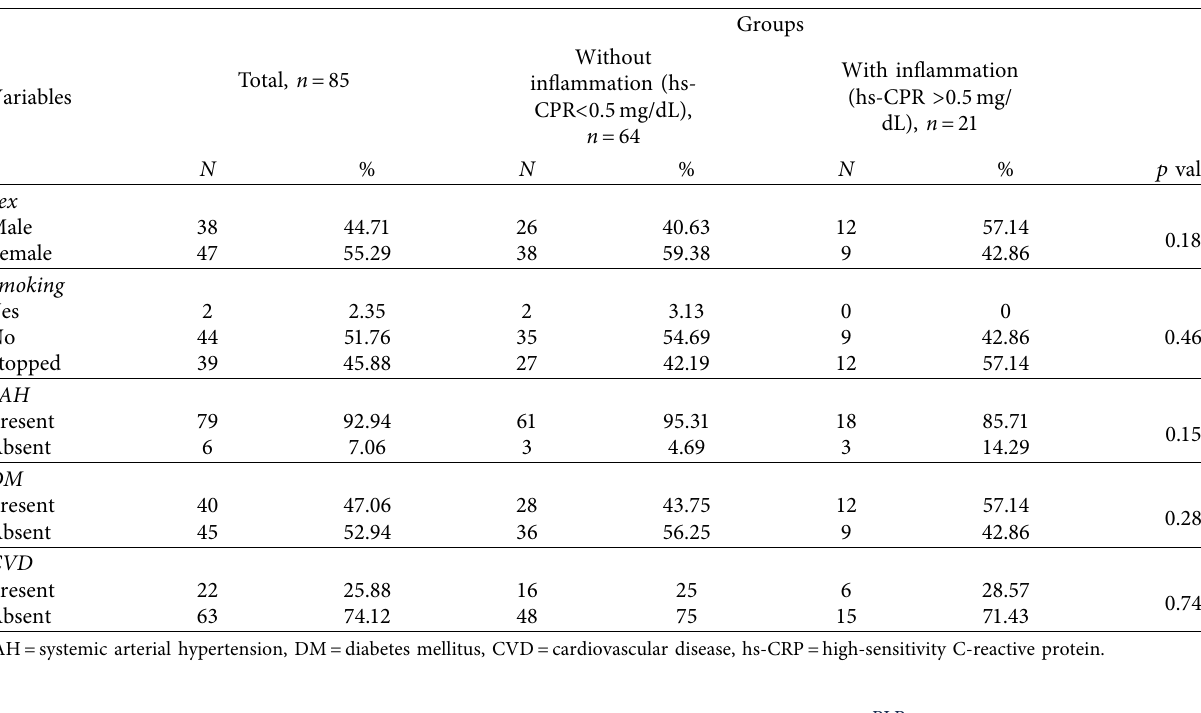
Table 1: Demographic and clinical characteristics of patients at the Kidney Disease Prevention Center of the University Hospital of the